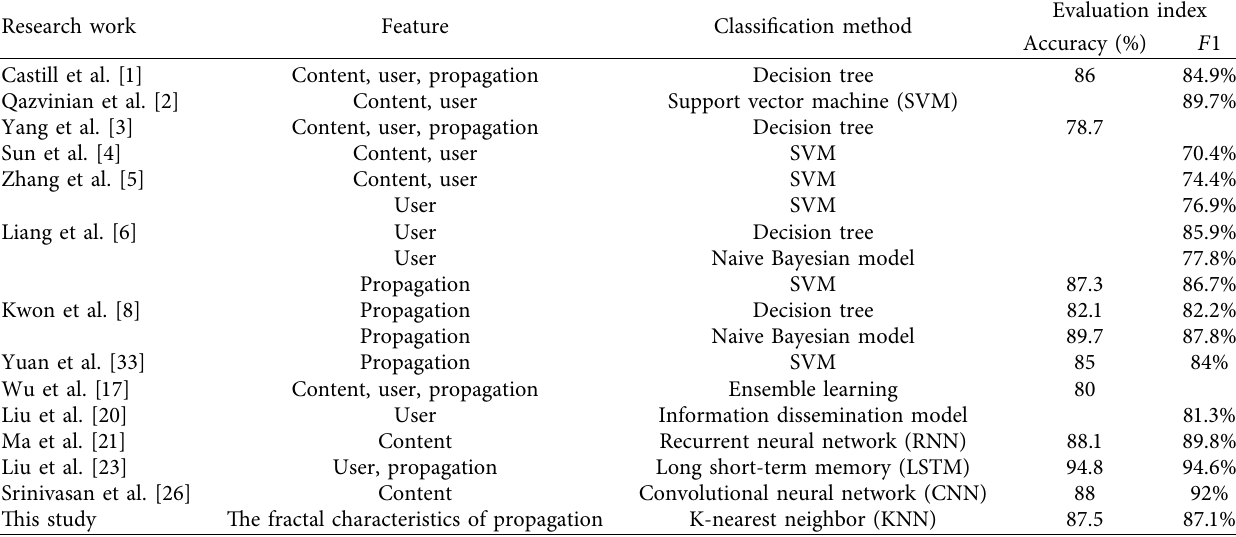
Table 6: Comparison of experimental results.